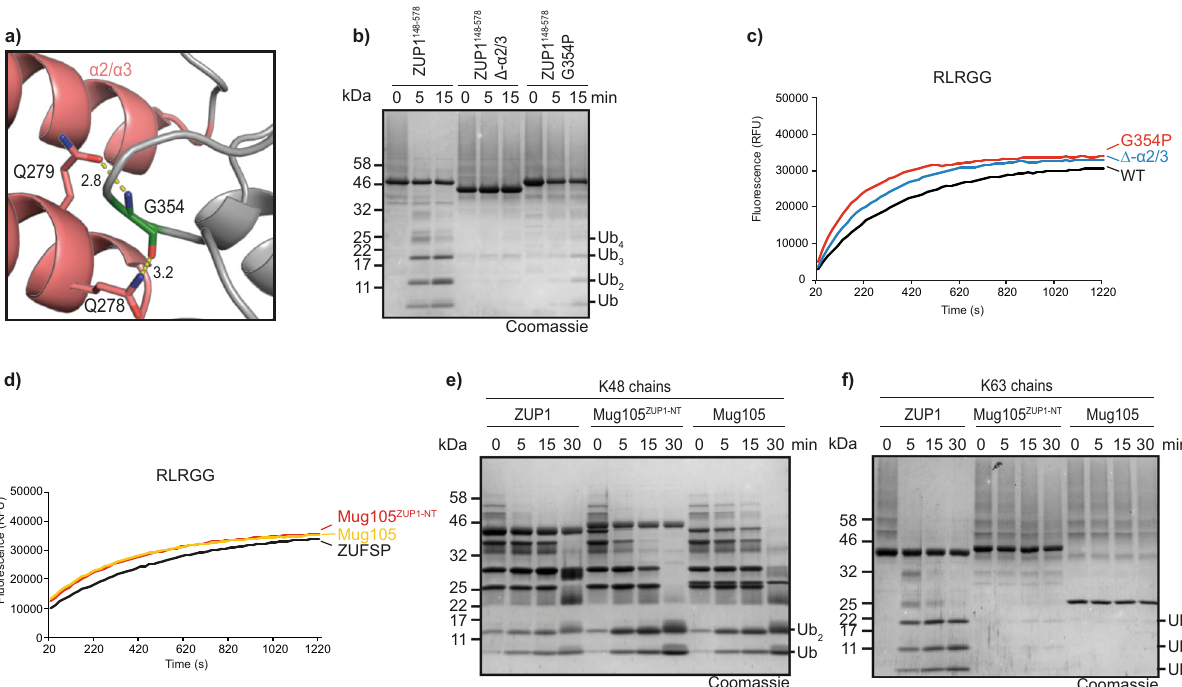
Fig. 7 Role of the α -2/3 region in chain cleavage. a The α -2/3 helices are rigidly connected with the catalytic core of ZUP1 (6EI1). The α -2/3 region is shown in cartoon representation and colored red. Gln-278 and Gln-279 contact Gly-354. These key residues are shown as sticks and hydrogen bonds are indicated by yellow dotted lines. b , c Activity assays of ZUP1 148 – 578 , the internal truncation ZUP1 148-578 Δ α -273 and G354P-mutated ZUP1 148 – 578 against K63-linked Ub 6 + chains ( b ) or RLRGG-AMC ( c ). d – f Activity assays of chimeric Mug105 ZUP1-NT against RLRGG-AMC ( d ), K48-linked ubiquitin chains ( e ), or K63-linked ubiquitin chains ( f ). The chimeric constructs consist of FL Mug105 to which the region 187 – 319 (ZnF4-MIU-zUBD- α 2/3) of human ZUP1 has been N-terminally fused. Source data are provided as a Source Data fi